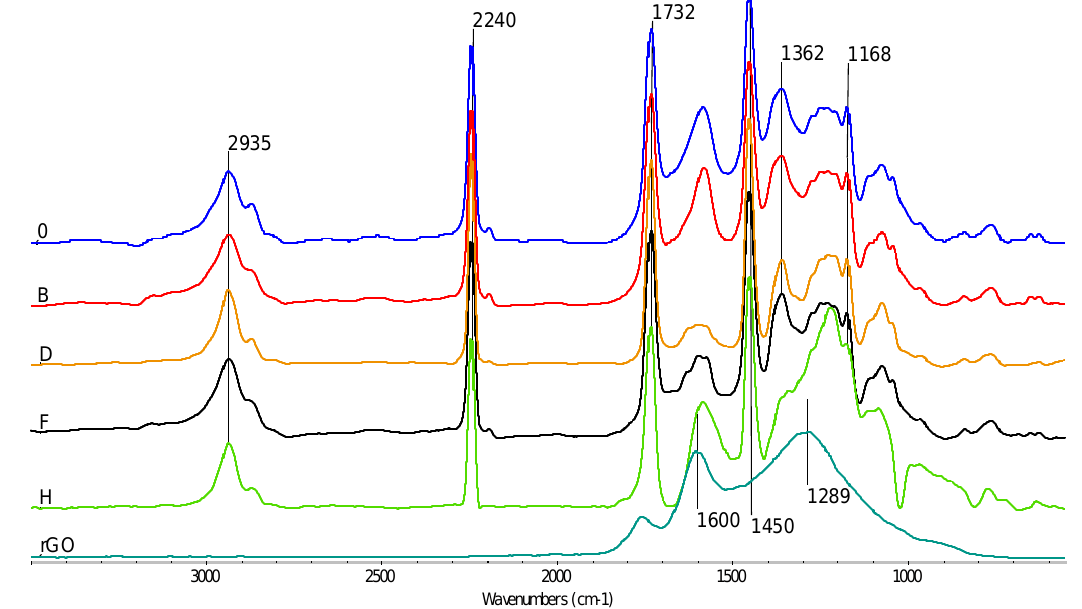
Figure 8. FTIR spectra of the composite rGO / PAN membranes ( B , D , F , H ), the pure PAN membrane and the pure rGO.